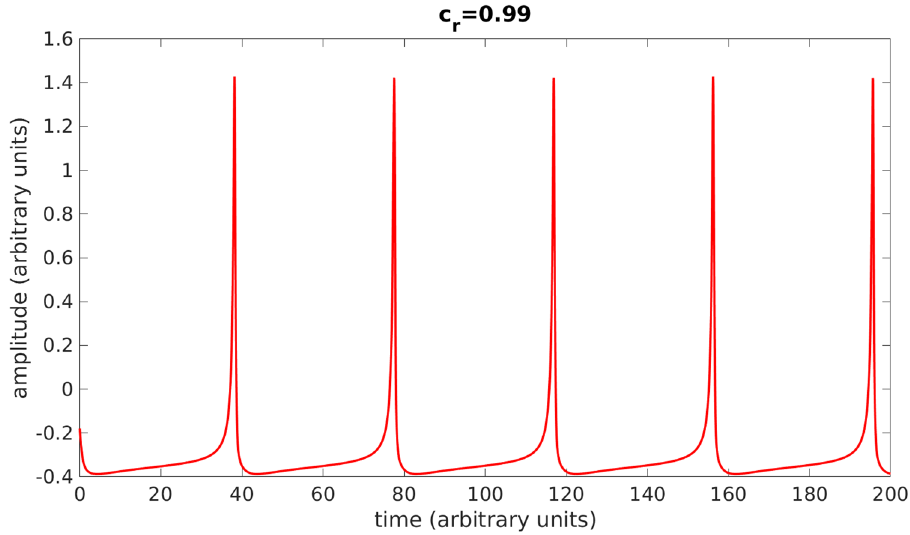
Figure 11. The amplitude and phase of a single mode for c r = 0.99 .